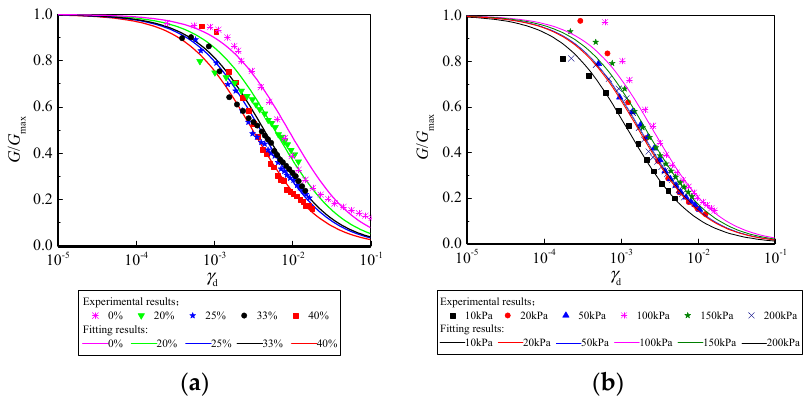
Figure 10. Shear modulus ratio G d / G max versus shear strain amplitude for various sawdust contents and confining pressures. ( a ) Shear modulus ratio G d / G max versus shear strain amplitude for the various sawdust contents; ( b ) Shear modulus ratio G d / G max versus shear strain amplitude for the various confining